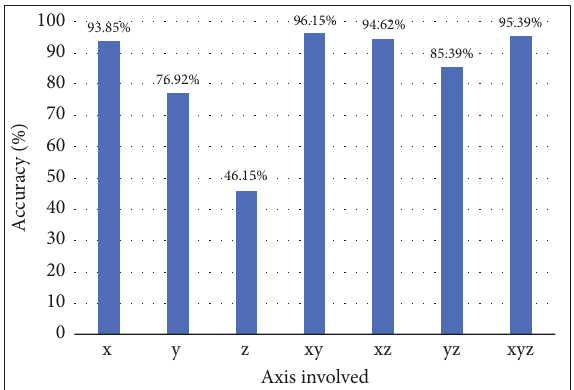
Figure 12: Plot of the accuracy across the axis involved.